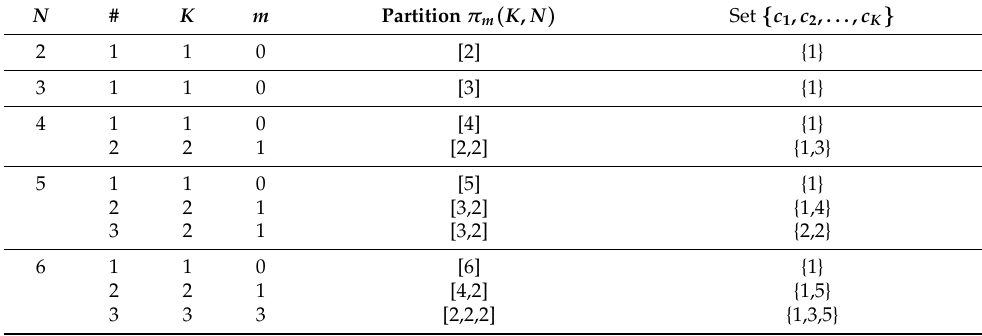
Table 3. Characteristics of the isospectral PT − symmetric BH-type Hamiltonians (21) with N ≤ 7. N # K m Partition π m ( K , N ) Set { c 1 , c 2 ,. . ., c K